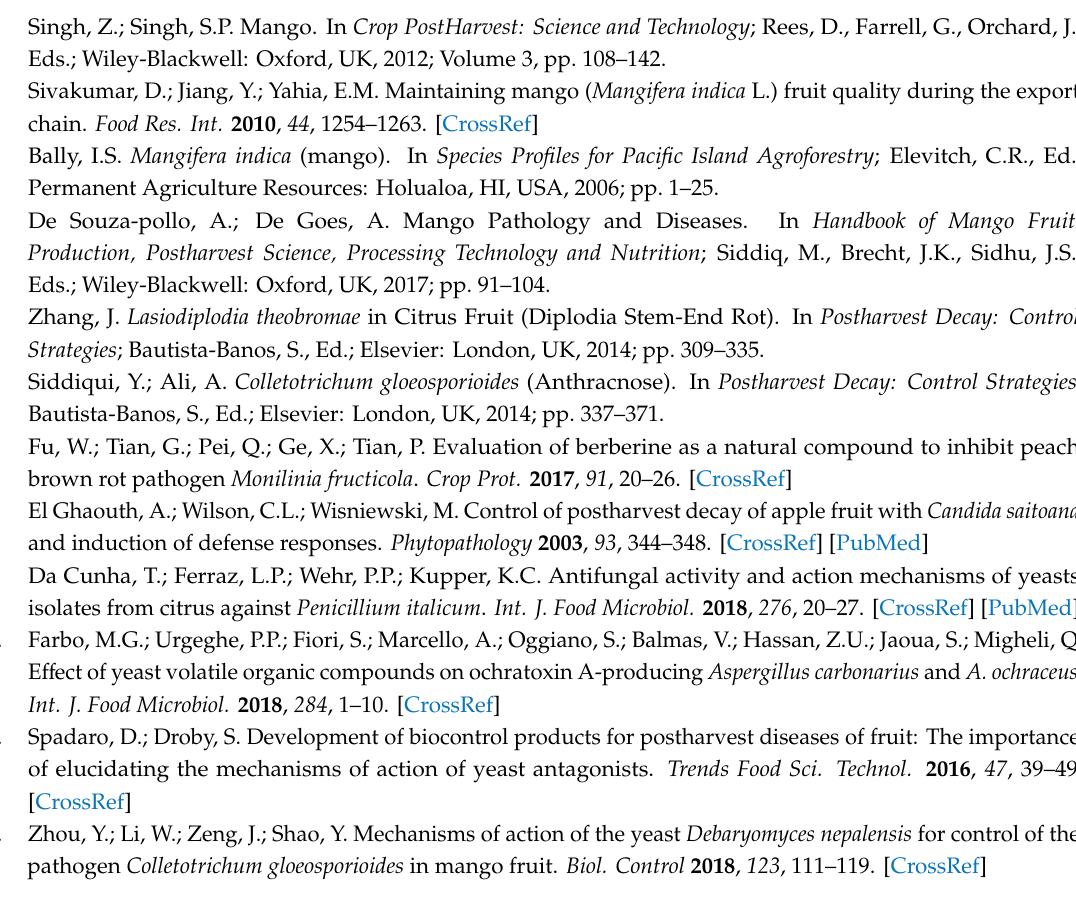
Supplementary Materials: The following are available online at http: // www.mdpi.com / 2076-2607 / 8 / 3 / 317 / s1. Table S1: Yeast species and strains belonging to phylum Ascomycota and phylum Basidiomycota, Table S2: Antagonistic activities of antagonistic yeast strains against L. theobromae and C. gloeosporiodes by dual cultivation on PDA plates and activities of VOCs produced by these strains by double plate technique at 25 ◦ C for 3 and 14 days,